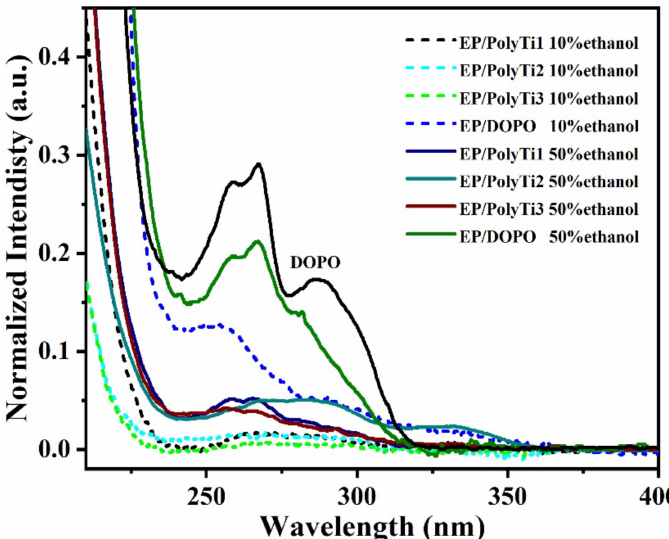
Figure 16. The UV-vis absorption spectra of the extraction solution of EP/PolyTi1 and EP/DOPO in 10% ethanol (dash line) and in 50% ethanol (solid